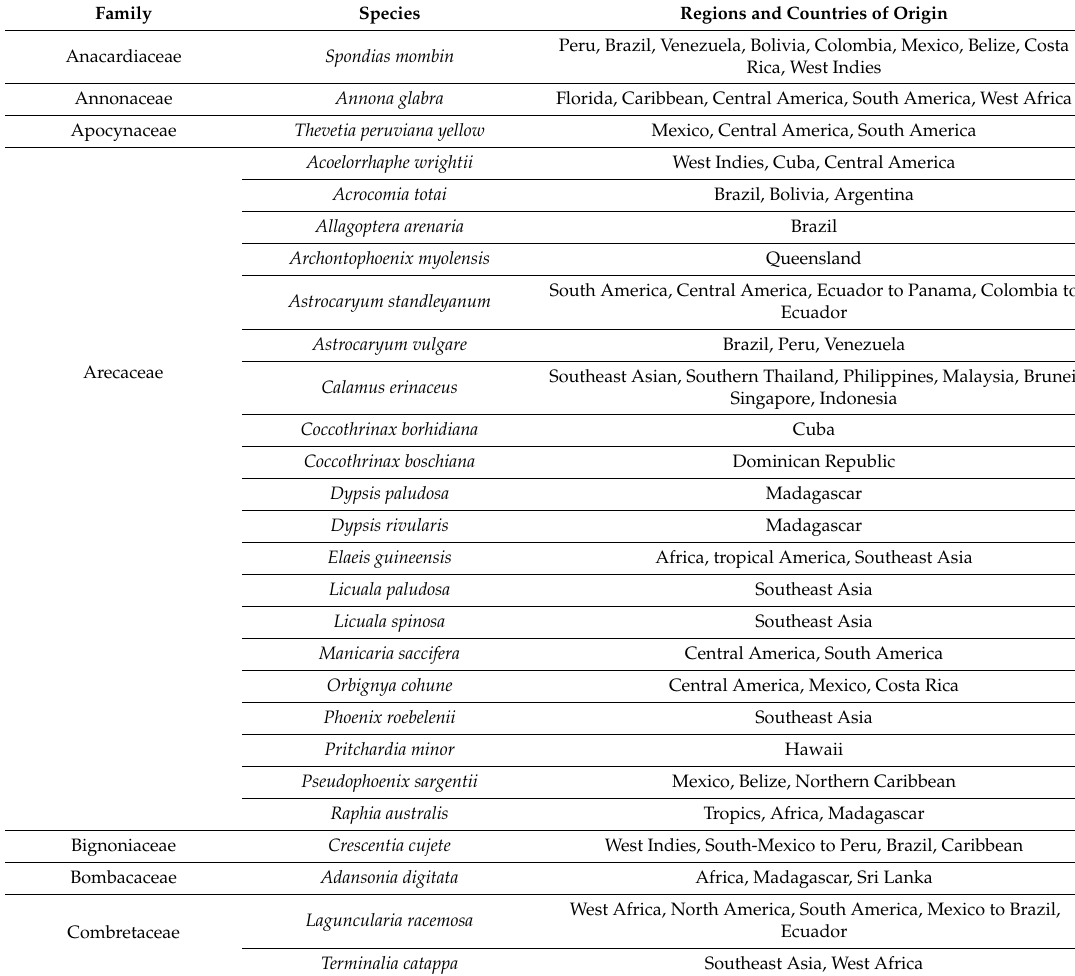
Table 1. List of selected drifting seeds used in the study. The table shows the plants families, the species names and the places of origin of the respective drifting